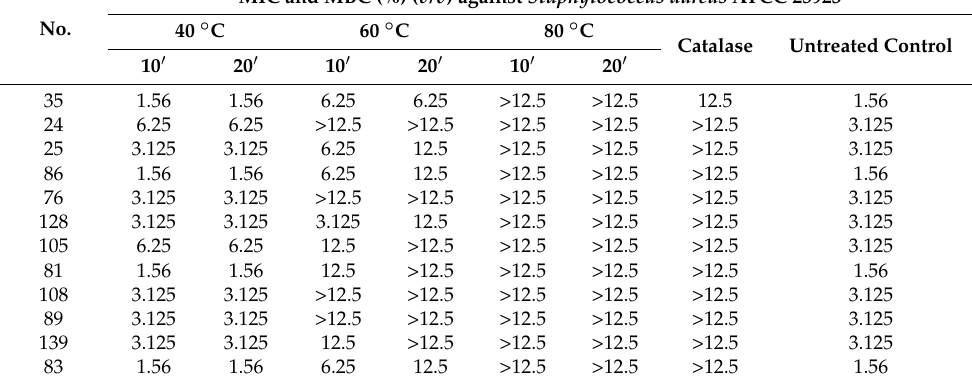
Table 5. Preliminary determination of mechanism of honeys activity–heat and catalase treatment.